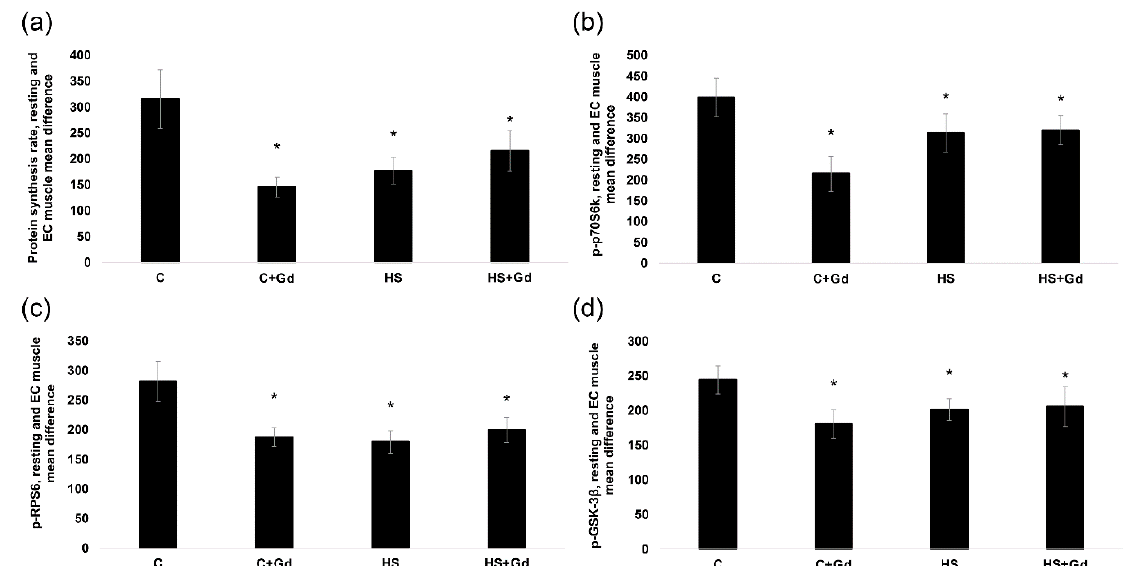
Figure 6. The mean difference in the rate of protein synthesis and phosphorylation of anabolic markers between resting and eccentrically-contracted muscles (experiment 2). ( a ): The rate of protein synthesis; ( b ): p70S6K (Thr389) phosphorylation; ( c ): RPS6 (Ser 240/244) phosphorylation; ( d ): GSK-3 β (Ser9) phosphorylation. Values are means ± SEM; n = 7/group. C—control animals, C+Gd—control animals with GdCl 3 treatment of the isolated soleus, HS—animals subjected to 7-day hindlimb unloading, HS+Gd—hindlimb-unloaded animals with GdCl 3 treatment of the isolated soleus. The data were analyzed using 2-way ANOVA with post hoc Tukey. Protein synthesis: the main effect of HS p = 0,026604, the main effect of EC p = 0,008589, interaction effect p = 0,026372; p70S6K (Thr389) phosphorylation: the main effect of HS p = 0,001192, the main effect of EC p = 0,023999, interaction effect p = 0,011959; RPS6 (Ser 240/244) phosphorylation: the main effect of HS p=0,002087, the main effect of EC p = 0,020173, interaction effect p = 0,062066; GSK-3 β (Ser9) phosphorylation: the main effect of HS p = 0,006279, the main effect of EC p = 0,001944, interaction effect p = 0,002417; *—significant difference vs. C group ( p < 0.05).